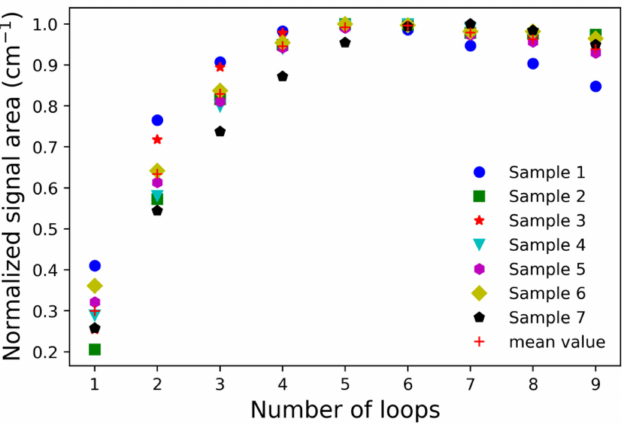
Figure 4. Adsorption isotherm of n -butane on SZ at T = 308 K for all experiments.